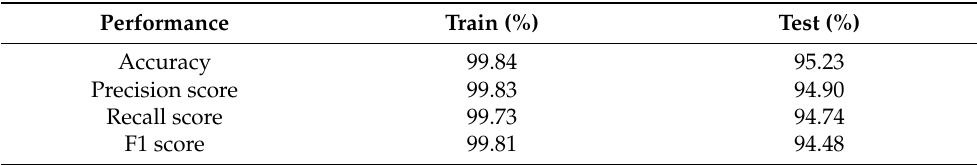
Table 4. The performance results of the proposed 1D-CNN